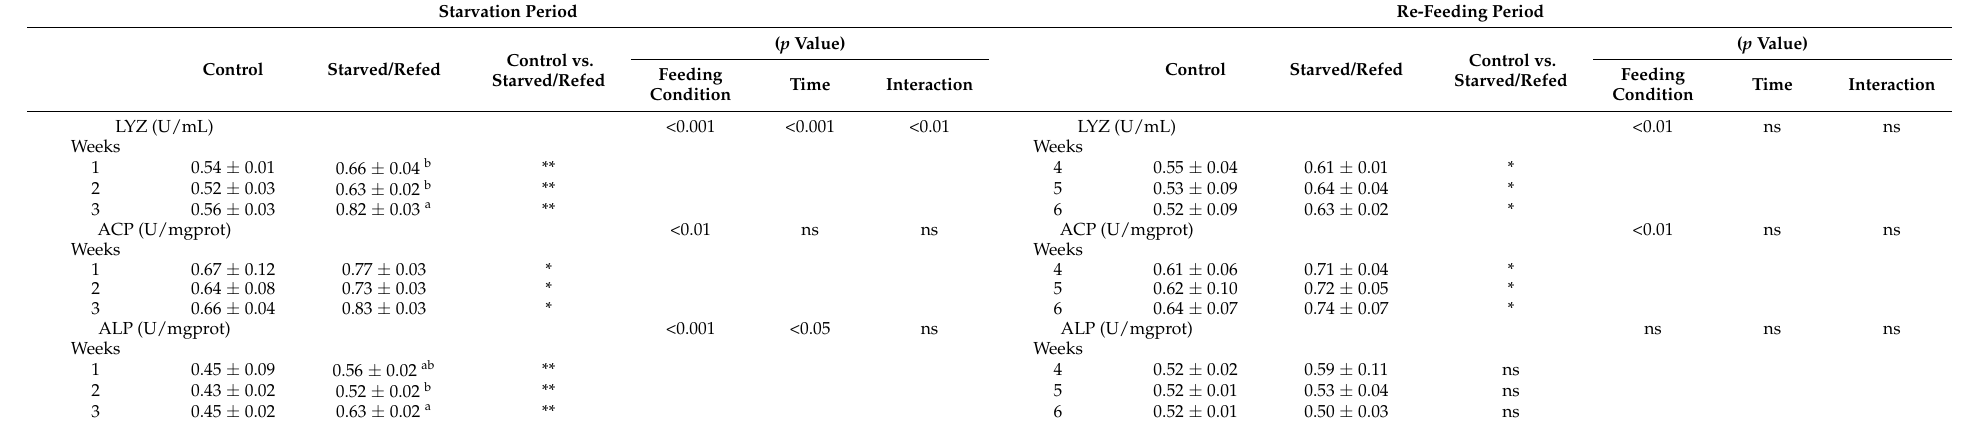
Table 7. Intestinal immune enzyme activities of O. macrolepis exposed to starvation and refeeding periods. Starvation Period Re-Feeding Period Interaction Feeding Condition Time Interaction